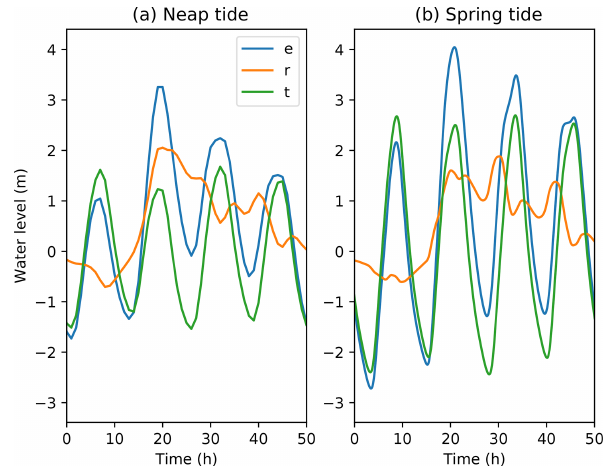
Figure 5. (a) The largest skew surge in the HadGEM3-GC3-MM 483-year surge-and-tide simulation, which happened to arrive on a neap tide. (b) The same atmospheric forcing applied to a spring tide. It can be seen that the realized skew surge is dependent on the tide in this case. Key: e: still water elevation. t: astronomical tide. r: residual (i.e. e − t). X axis shows time in hours with arbitrary